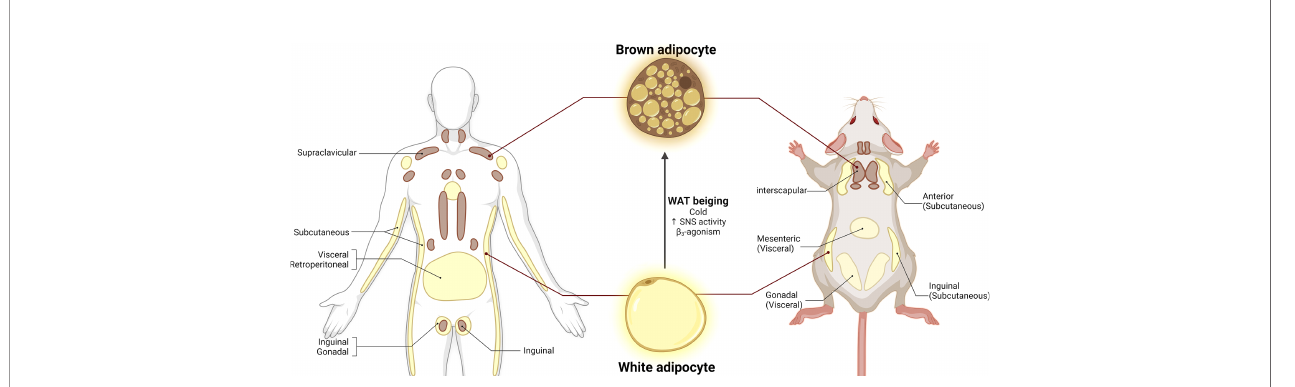
FIGURE 1 | Adipose tissue distribution in humans and mice. White adipose tissue (WAT) is composed of unilocular white adipocytes characterized by a single large lipid droplet. Brown adipose tissue (BAT) consists of brown adipocytes with small lipid droplets and high mitochondrial density. White adipocytes can adopt brown- like morphology under cold exposure, increased SNS activity and b 3-agonism, a process called WAT beiging. Adapted from (36). Figure 1 license number: XB23OHGTZA, Figure 2 license